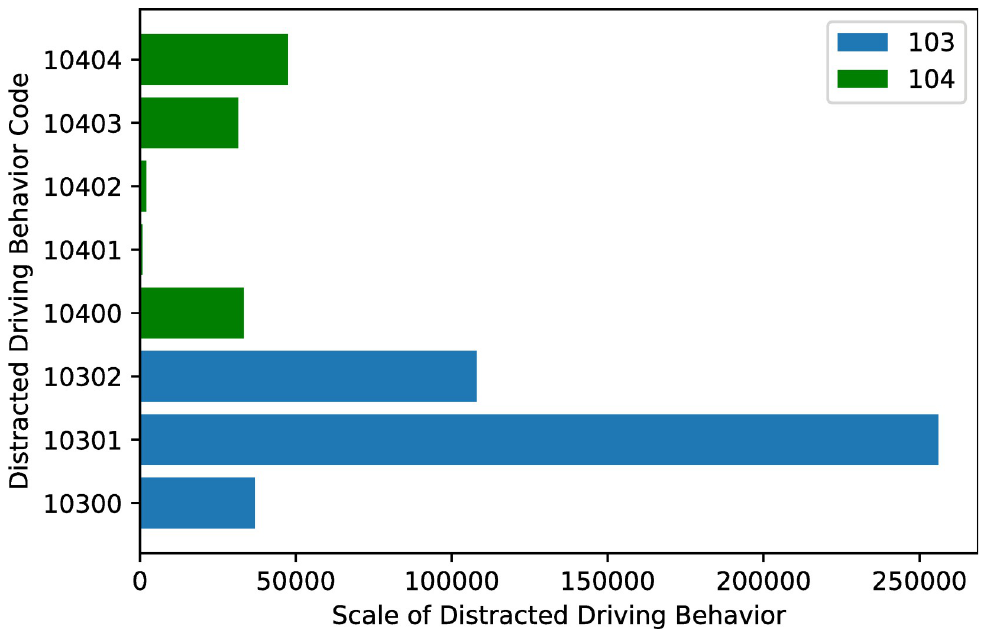
Fig 4. Scale of each distracted driving behavior